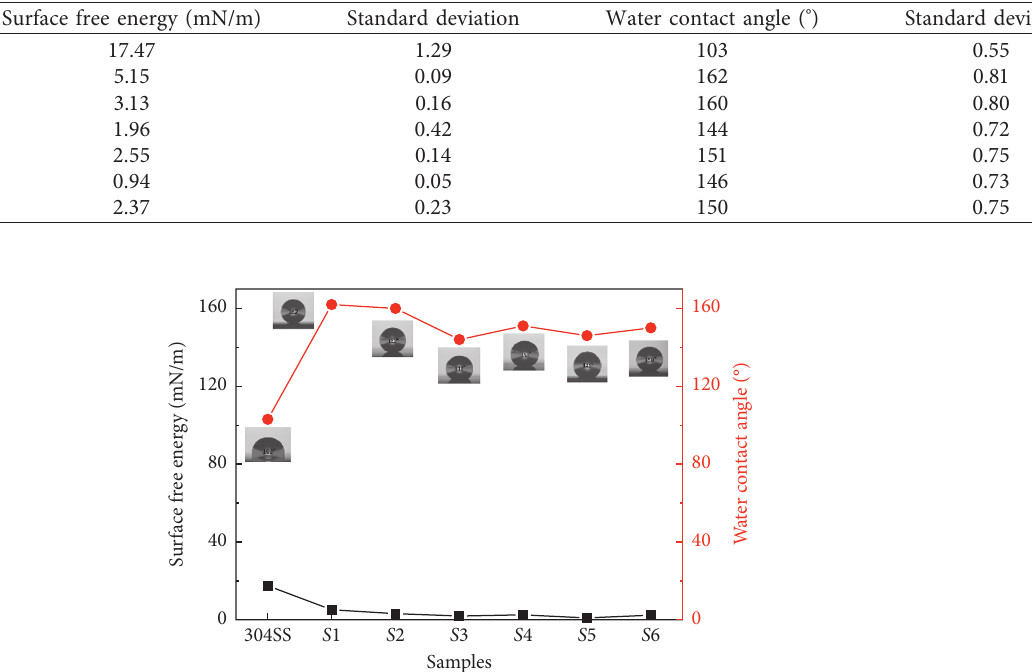
Figure 2: Comparison of surface free energies and water contact angles of specimens after femtosecond laser irradiation. Table 2: Surface free energies and CAs of laser-treated specimens after fluorination.